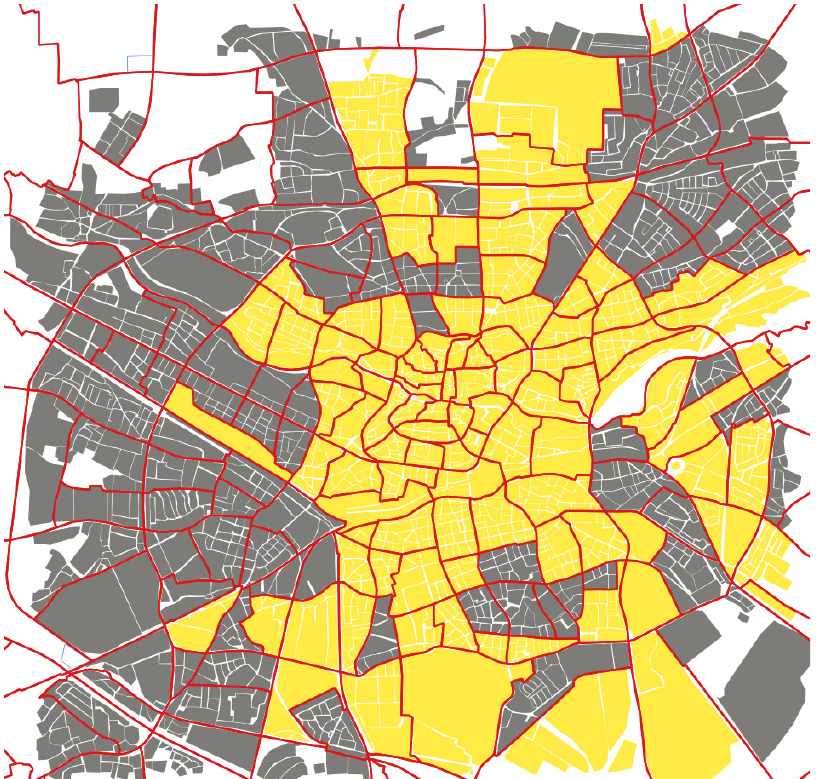
Figure 10. Level of damage for building blocks for the central area of Nuremberg, reflecting the district‐level BDI from Figure 4. Note: Higher levels of damage in yellow and lower levels of damage in